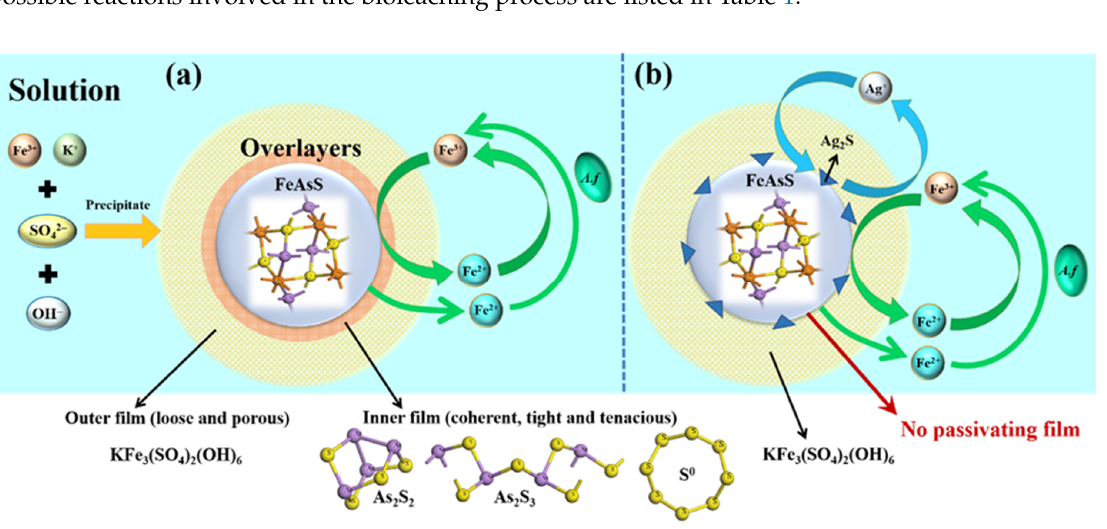
Figure 6. Schematic diagram of the mechanisms for the bioleaching of arsenopyrite ( a ) without and ( b ) with Ag + . Table 1. Possible reactions involved in the oxidative leaching of arsenopyrite in the presence of Ag + . Oxidative Dissolution of